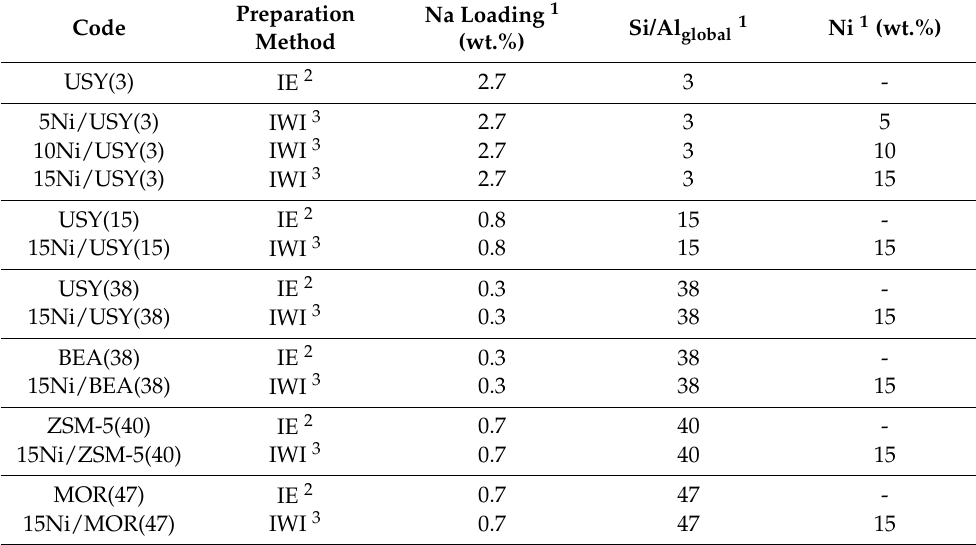
Table 1. Main characteristics of the catalysts studied in the present work.